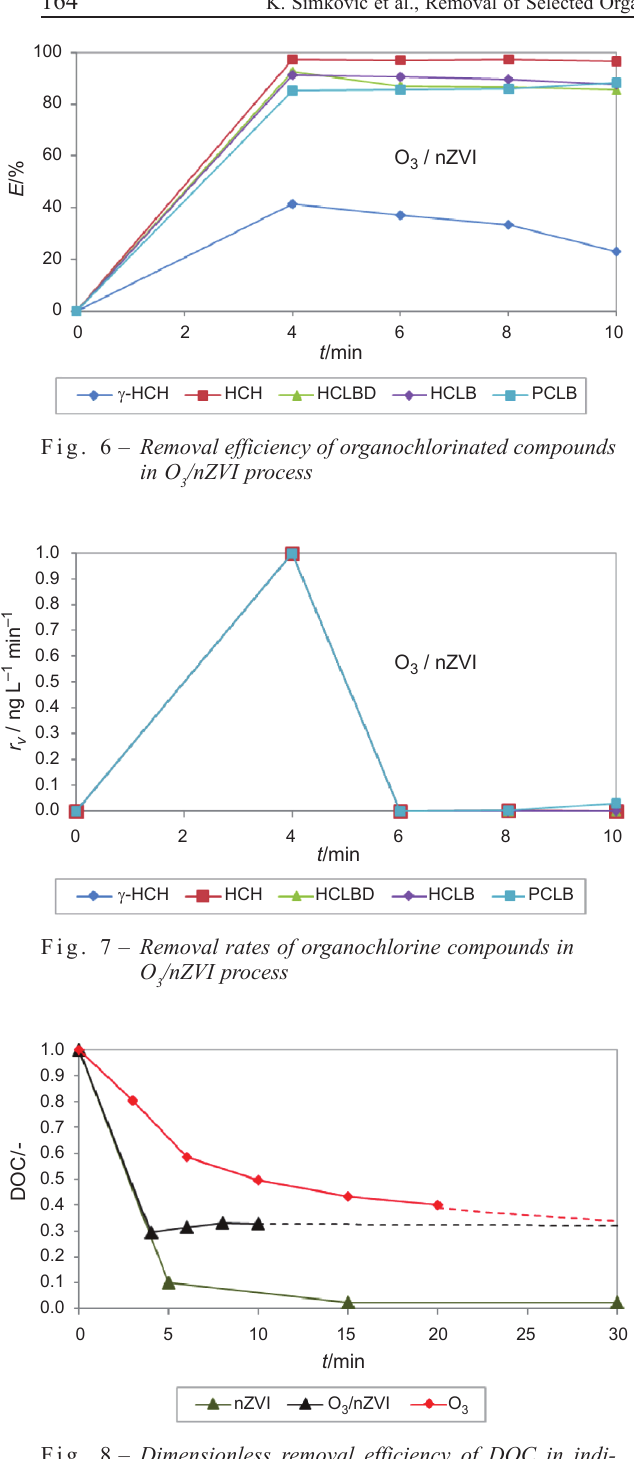
Fig. 8 – Dimensionless removal efficiency of DOC in indi - vidual